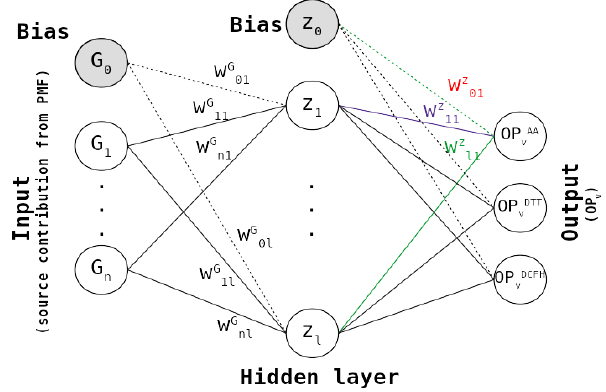
Figure 2. The MLP neural network architecture used in this study, where n refers to the number of sources, G is the normalized contri- bution from the PMF, and OP v is the different volume-normalized OP activities (OP DTT v , OP AA v , and OP DCFH v